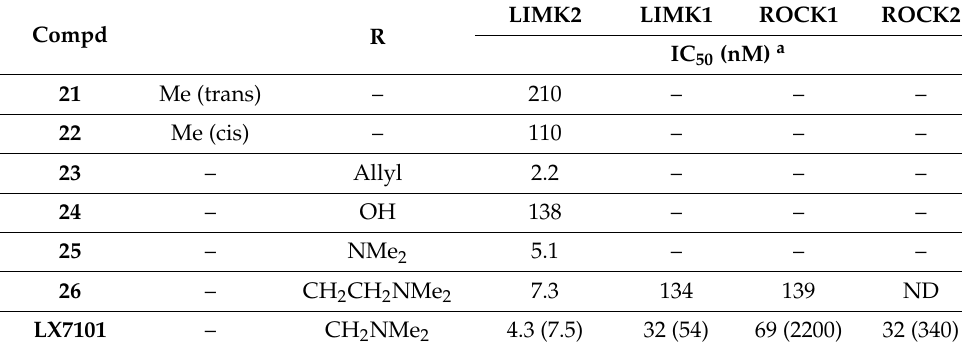
Figure 5. SAR optimization of compound 20. Table 2. Water-stable amides and in vitro/in vivo assays.